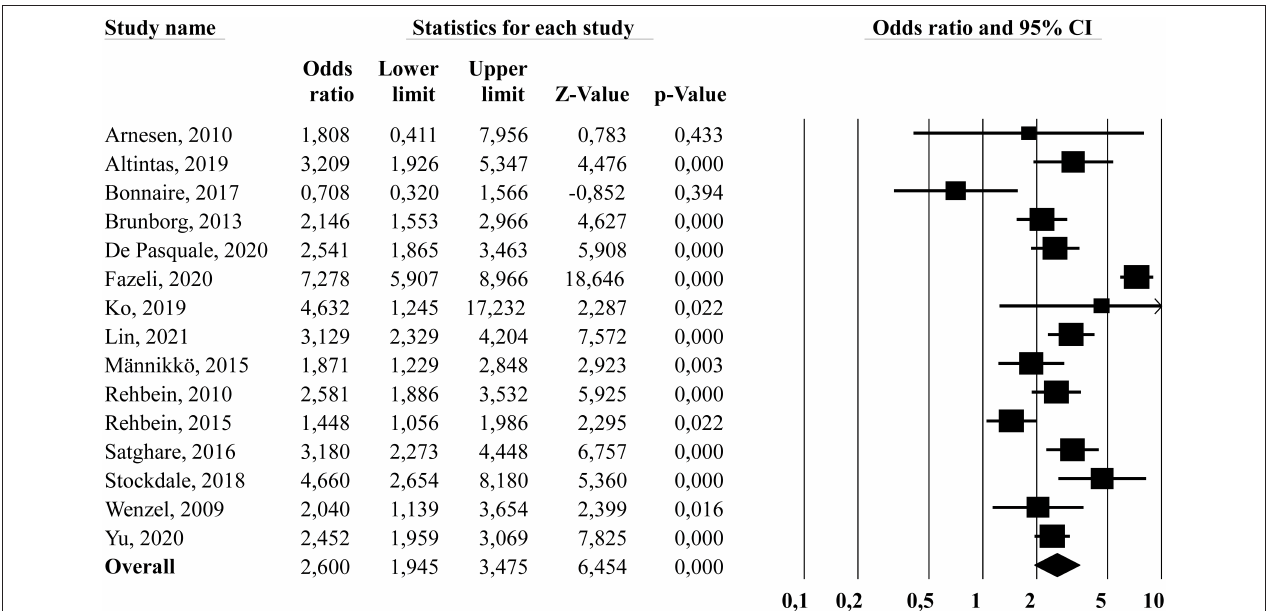
FIGURE 5 | Forest plot showing the association (odds ratio) between problematic gaming and sleep problems.